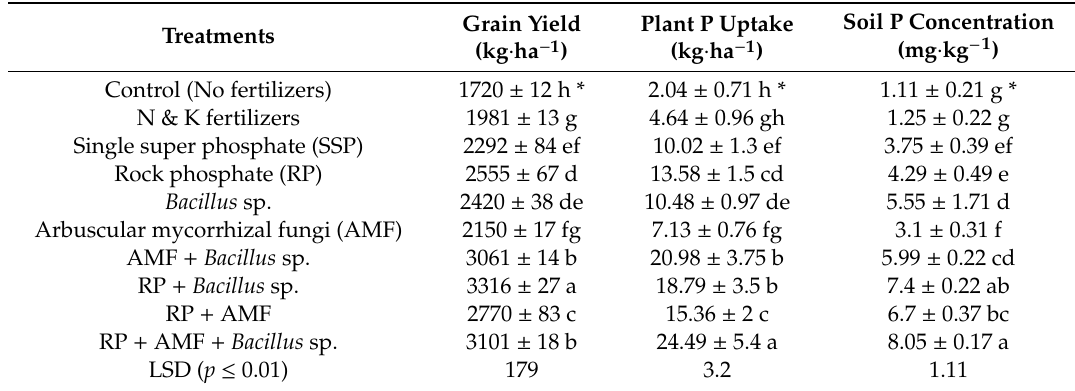
Table 5. The residual e ff ect of AMF and PSB with RP on soil P concentration in post-harvest wheat crop. Grain Yield Treatments